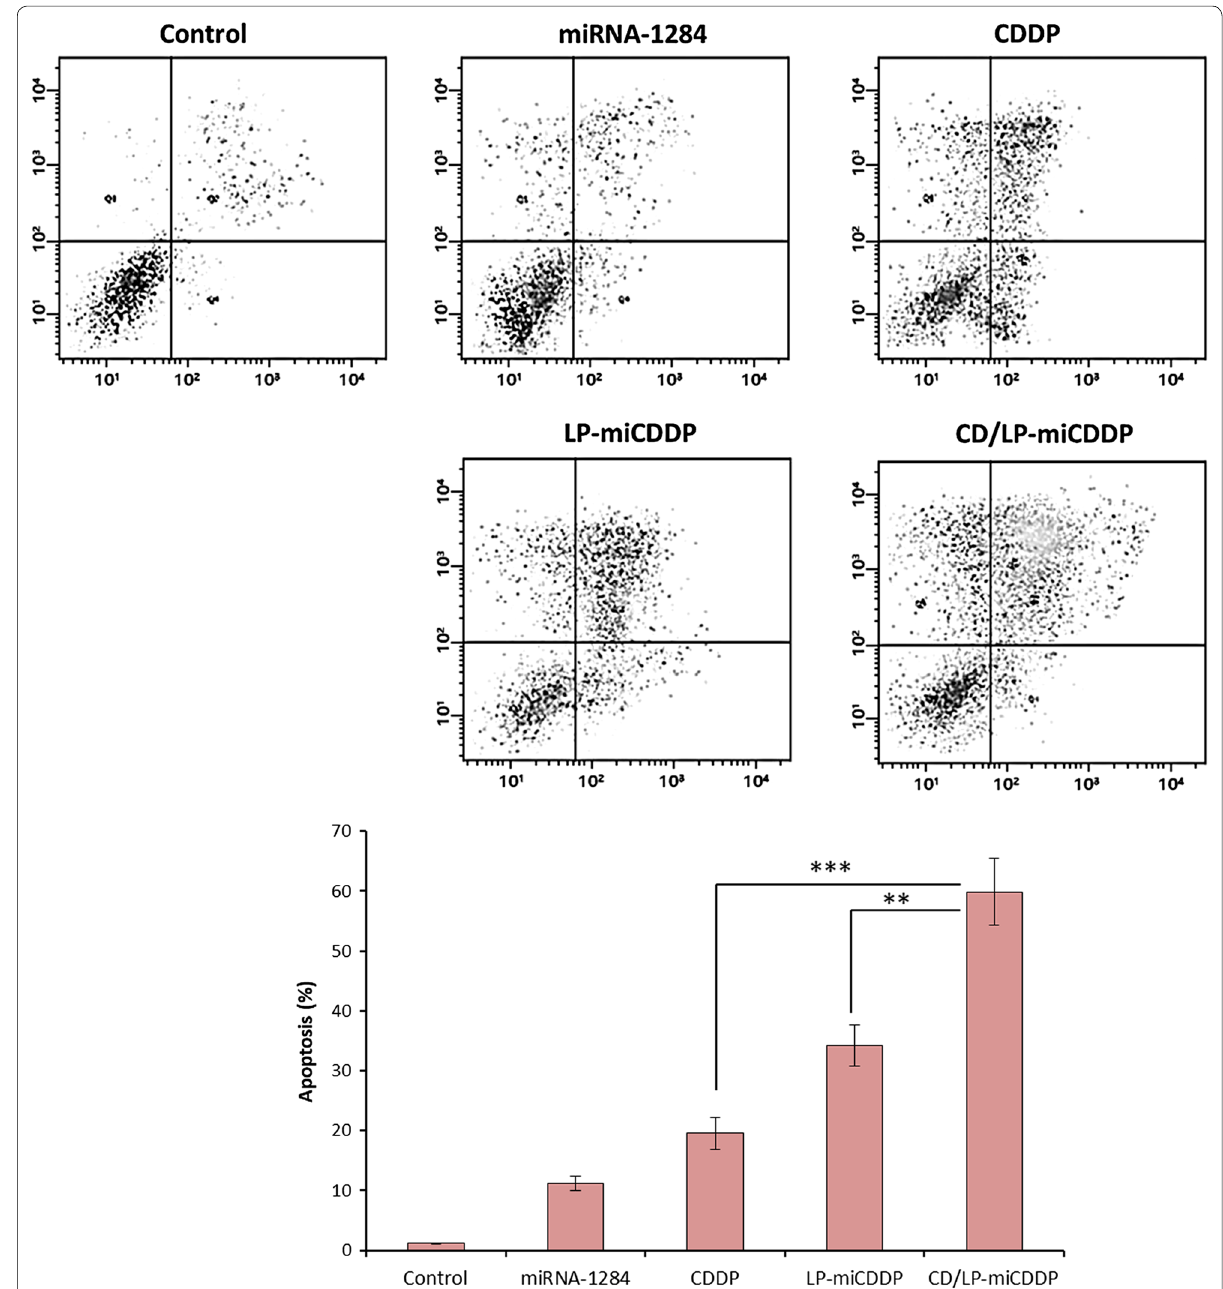
Fig. 7 Quantitative apoptosis analysis of of HeLa cancer cells after treatment with miR‑1284, CDDP, LP‑miCDDP and CD/LP‑miCDDP. The cells were stained with Annexin V‑FITC and PI and 10,000 cell events were observed at flow cytometer. ***p < 0.0001, CD/LP‑miCDDP vs free CDDP; **p < 0.001, CD/LP‑miCDDP and vs